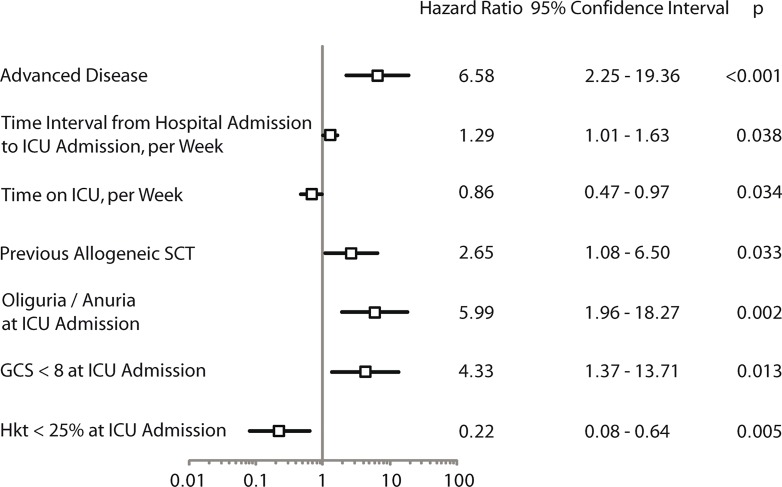
Hazard ratio (HR) plot of parameters associated with survival after ICU (intensive care unit) discharge.Abbreviations: SCT, stem cell/bone marrow transplantation; GCS, Glasgow Coma Scale; Hkt, hematocrit.